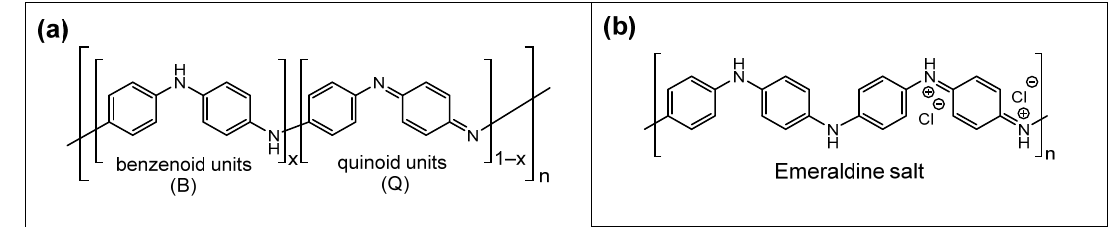
Figure 2. Structures of PANI: ( a ) general structure showing benzenoid (B) and quinoid (Q) units in its base form; and ( b ) emeraldine salt (PANI-ES). Adapted from [64,65]. The x-value is defined as the fraction of benzenoid (B) and quinoid (Q) units, as follows: -(B) x -(Q) 1-x - for a given degree of polymerization (n), according to panel ( a ). Table 3. PANI in various forms and oxidation states *.